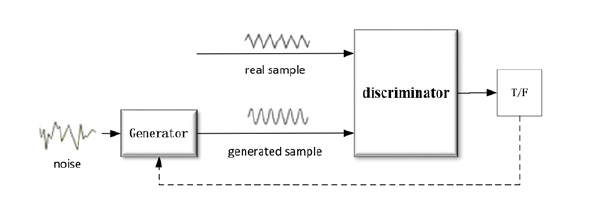
Figure 1. Generative adversarial